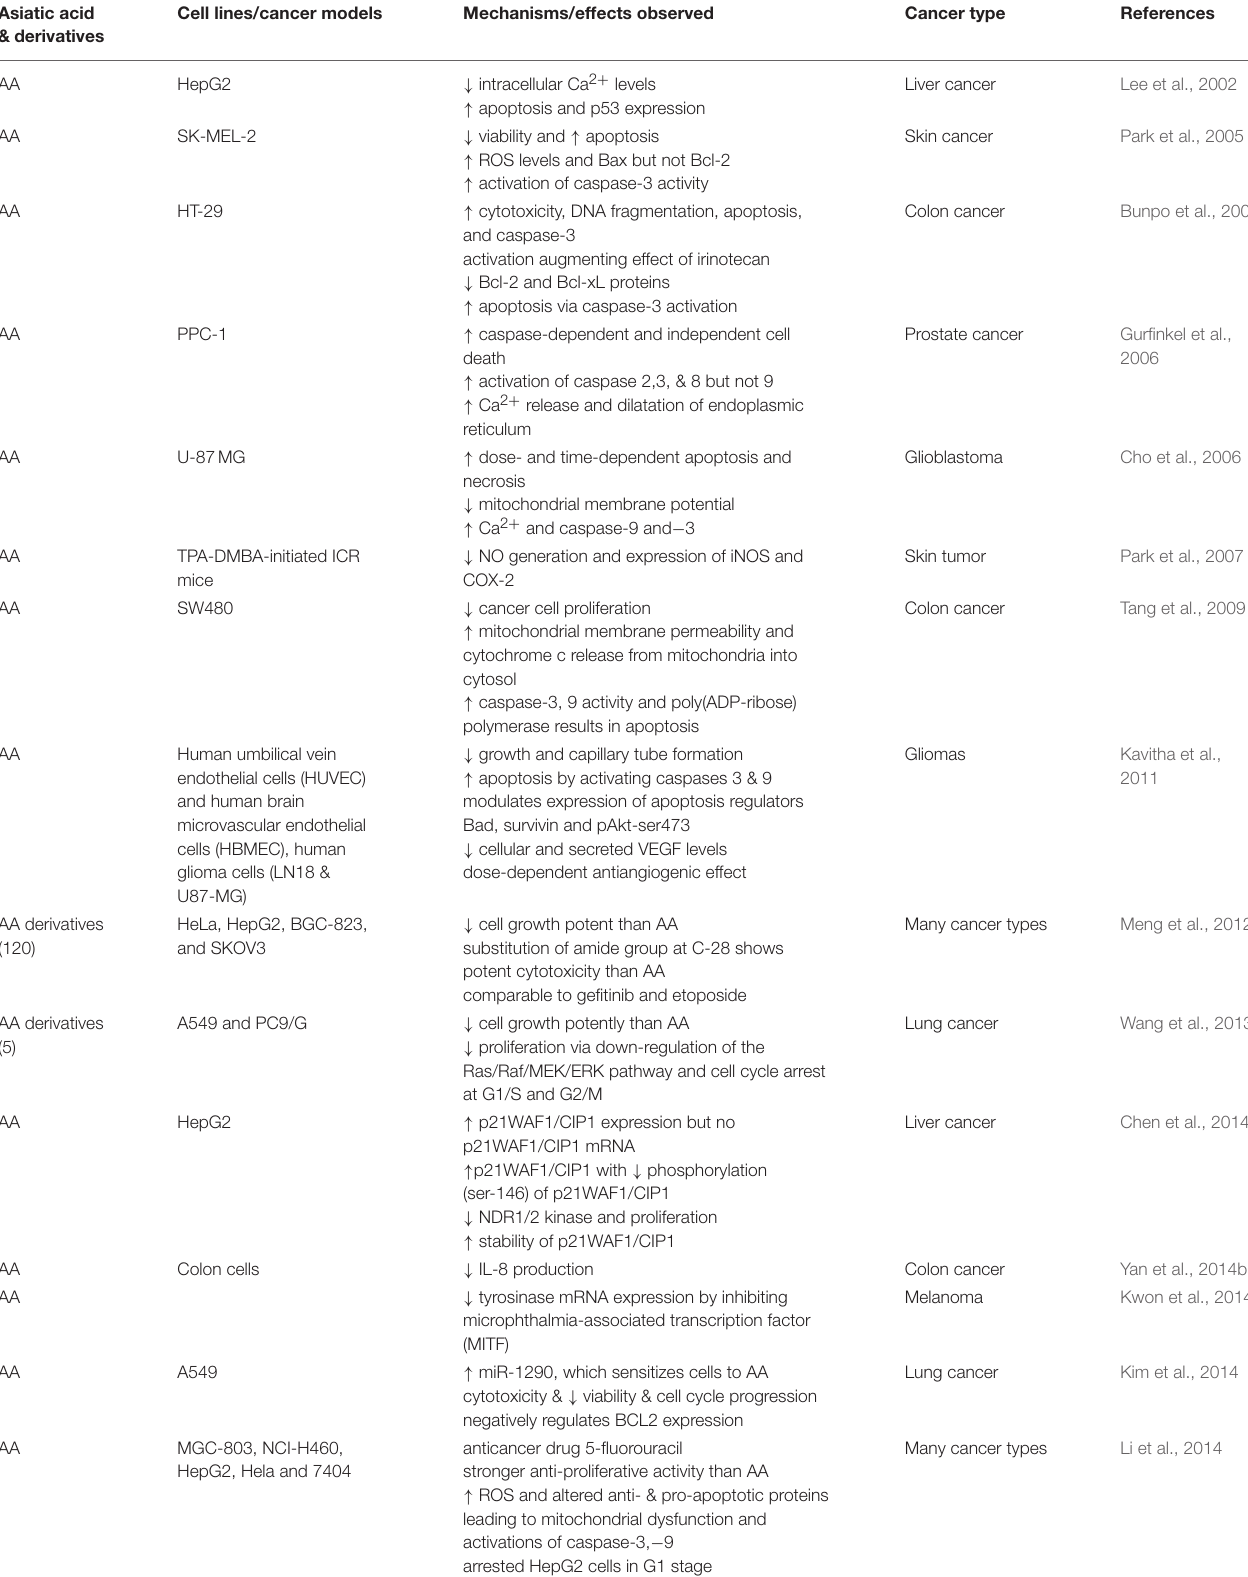
TABLE 7 | The anticancer activities and mechanism of Asiatic acid in different cancer types. Asiatic acid &